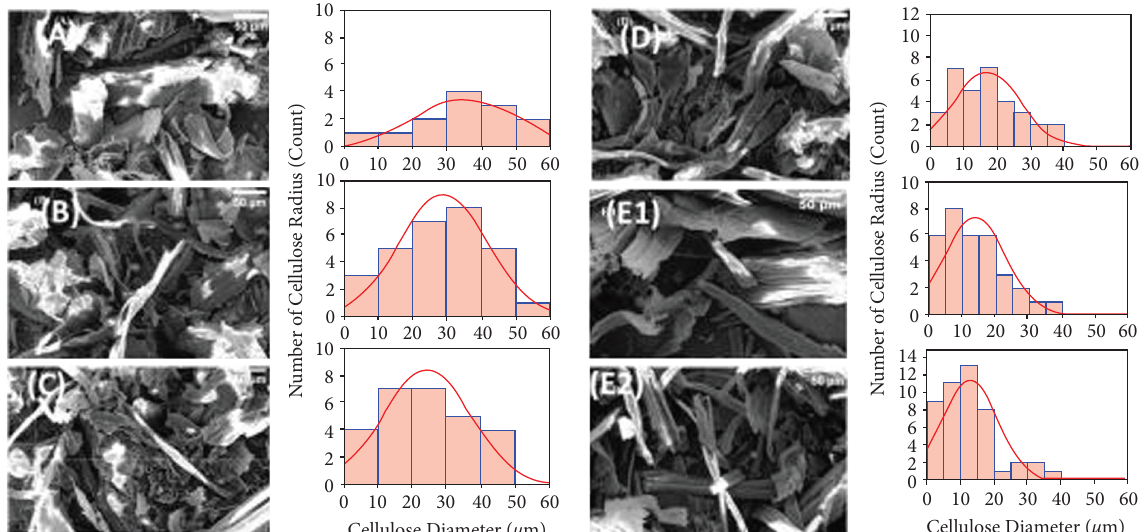
Figure 5: SEM micrographs of cellulose extracted from sugarcane